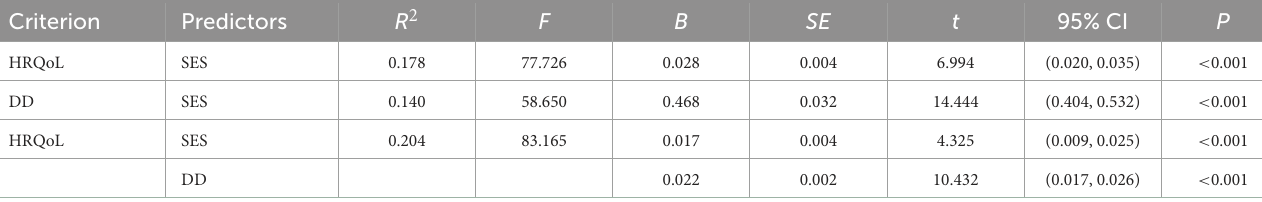
TABLE 3 Regression coefficients in the mediation analysis between SES on HRQoL with DD as mediator ( N = 3,250).